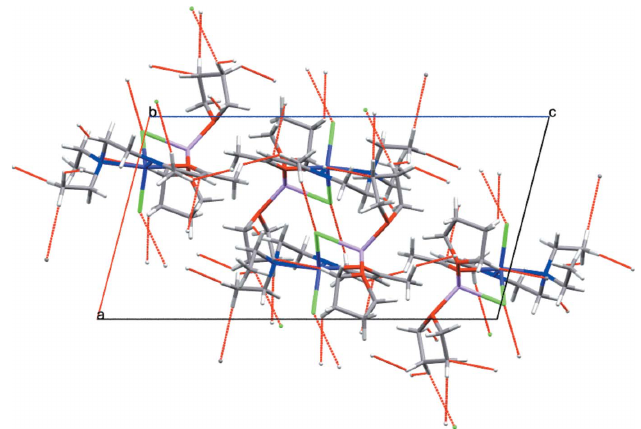
Figure 1 Molecular structure of the title compound with displacement ellipsoids drawn at the 50% probability